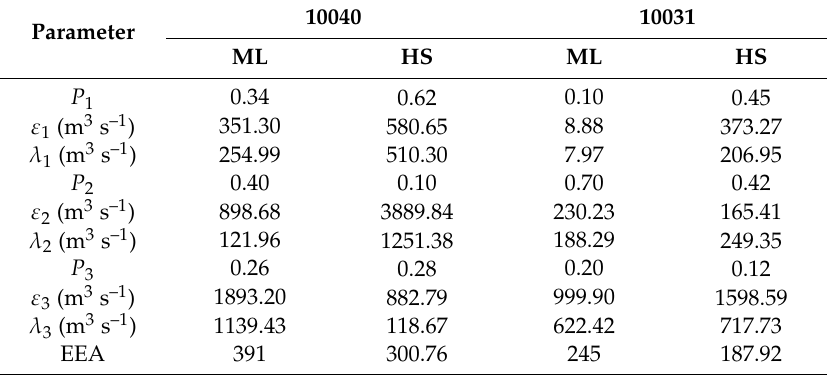
Table 5. Comparison of parameters obtained in the EV1-3P using Maximum Likelihood (ML) and harmonic search (HS) methods.